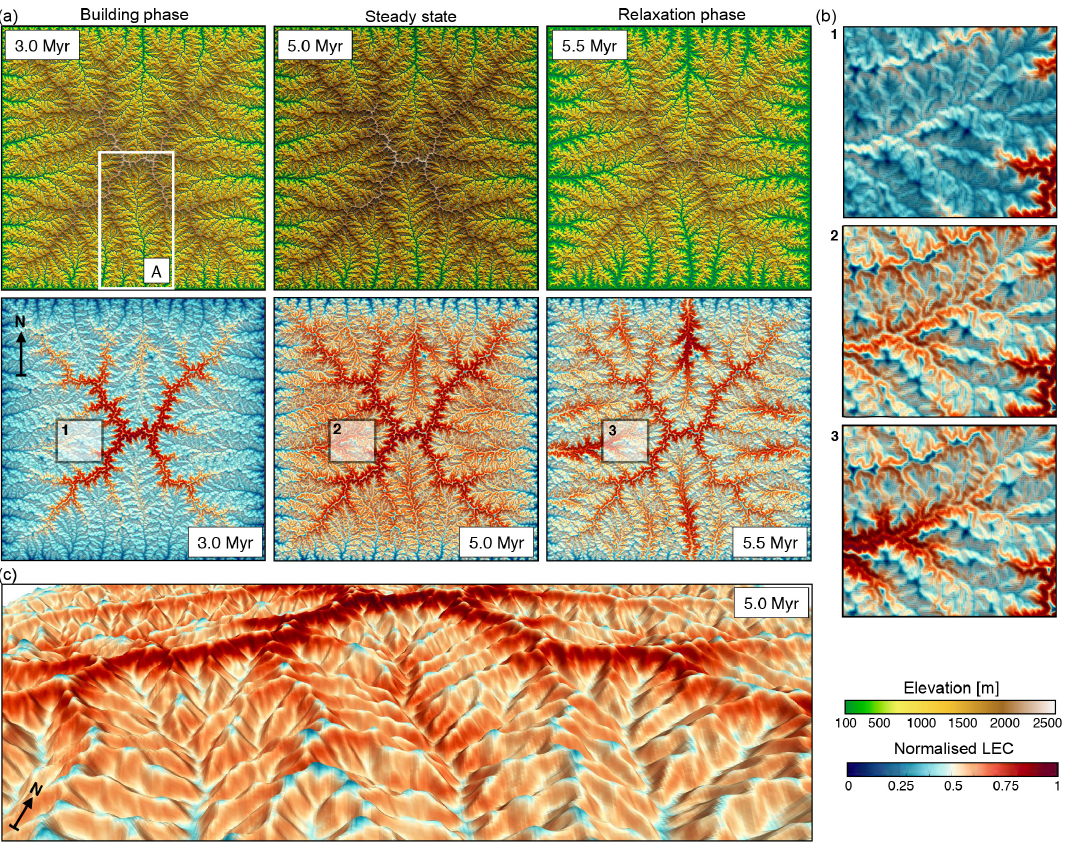
Figure 2. Outputs from the uniform precipitation (1myr − 1 ) model. (a) The top row presents the evolution of the landscape at three time steps during the mountain-building phase (induced by a uniform uplift of 1mmyr − 1 ), just before the cessation of uplift at 5.0Myr (landscape is at steady state, i.e. erosion balances uplift) and during the early phase of mountain collapse (5.5Myr). The bottom row shows the spatial distributions of normalised LEC for the three considered time steps. (b) Detailed maps presenting changes in normalised LEC for regions 1, 2, and 3 defined in panel (a) and illustrating the geomorphic controls on LEC variability over time. (c) 3-D view of the spatial patterns of the LEC index at 5Myr with generally low LEC for valleys, minor peaks lower on the ridges, and high LEC on ridge